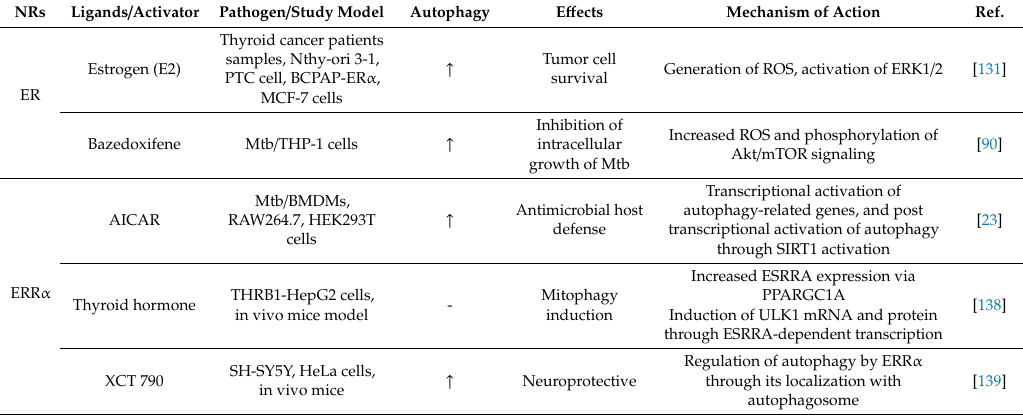
Table 2. Estrogen receptors (ERs) / estrogen-related receptors